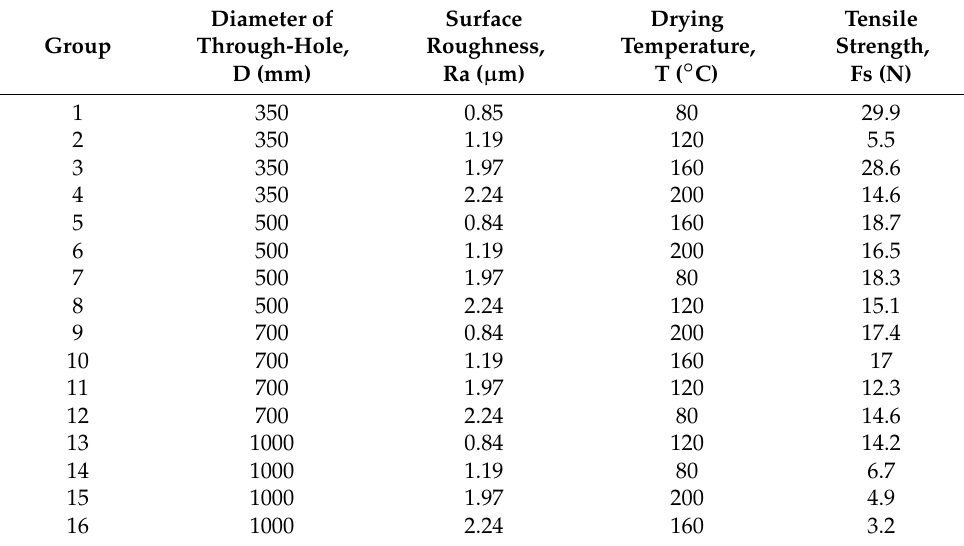
Table 2. Orthogonal experiments and tensile measurement